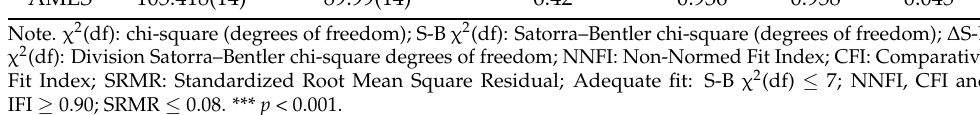
Table 2. Fit indices for the attitudes towards Maghrebis in education Scale (AMES). χ 2 (df) *** S-B χ 2 (df) *** AMES